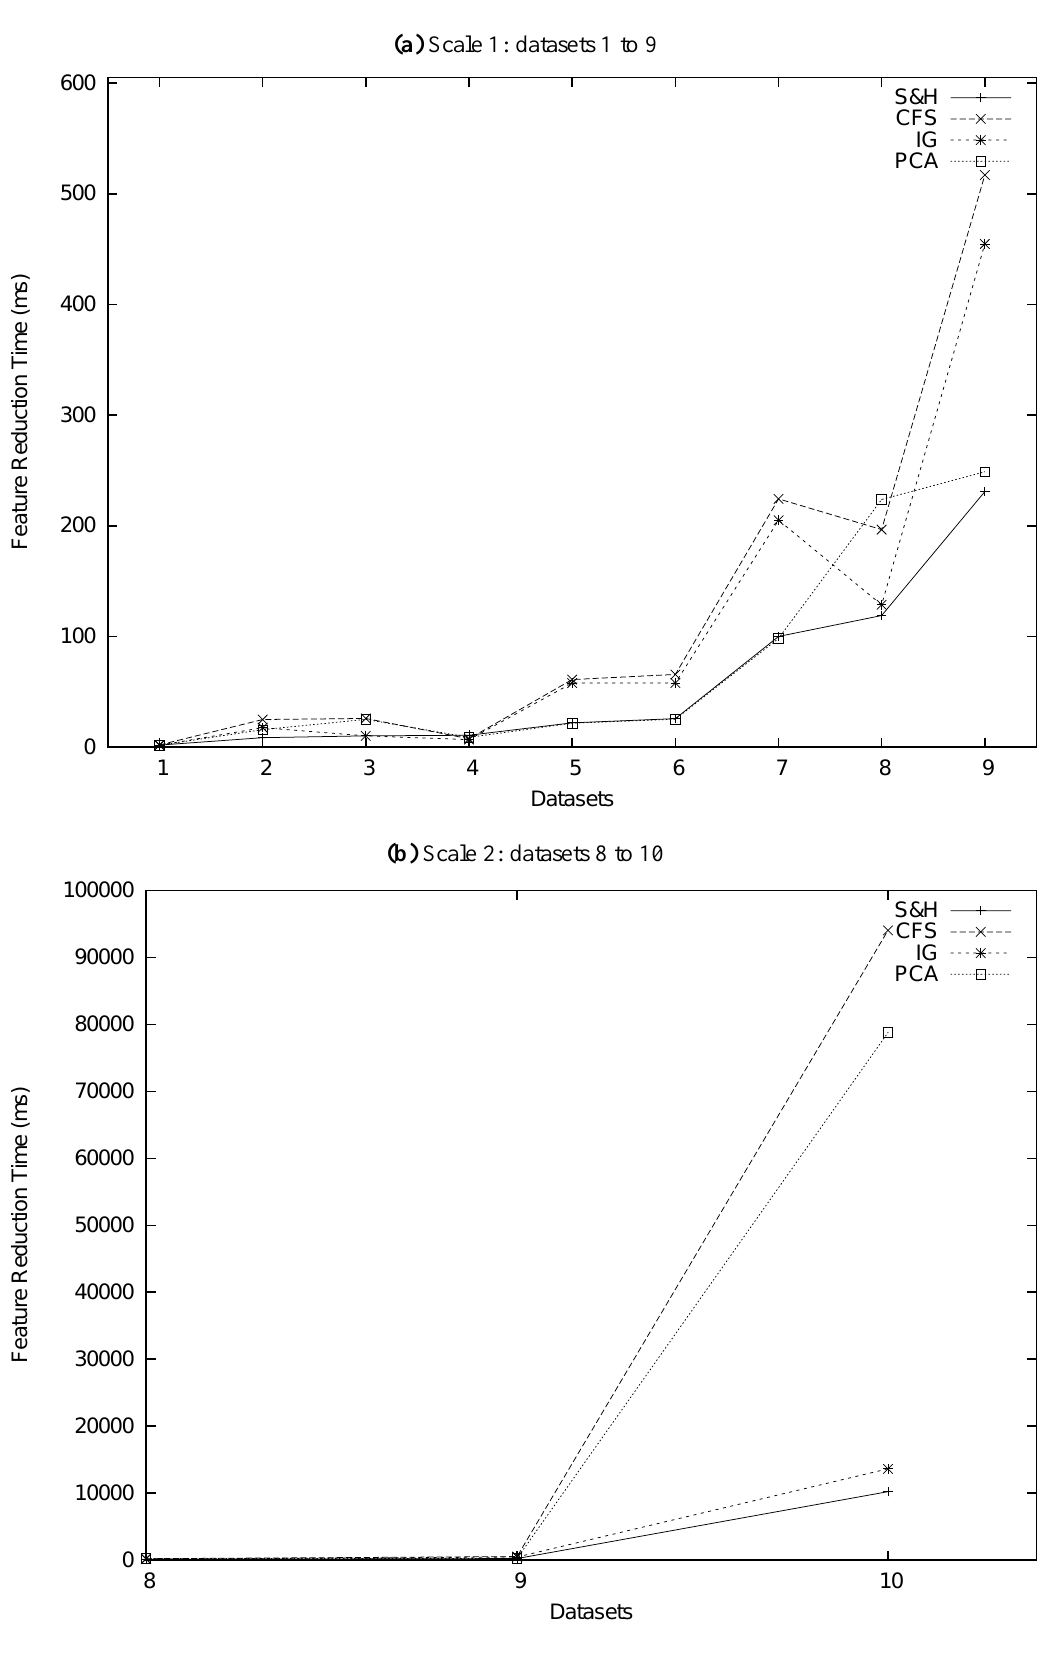
(b) Scale 2: datasets 8 to